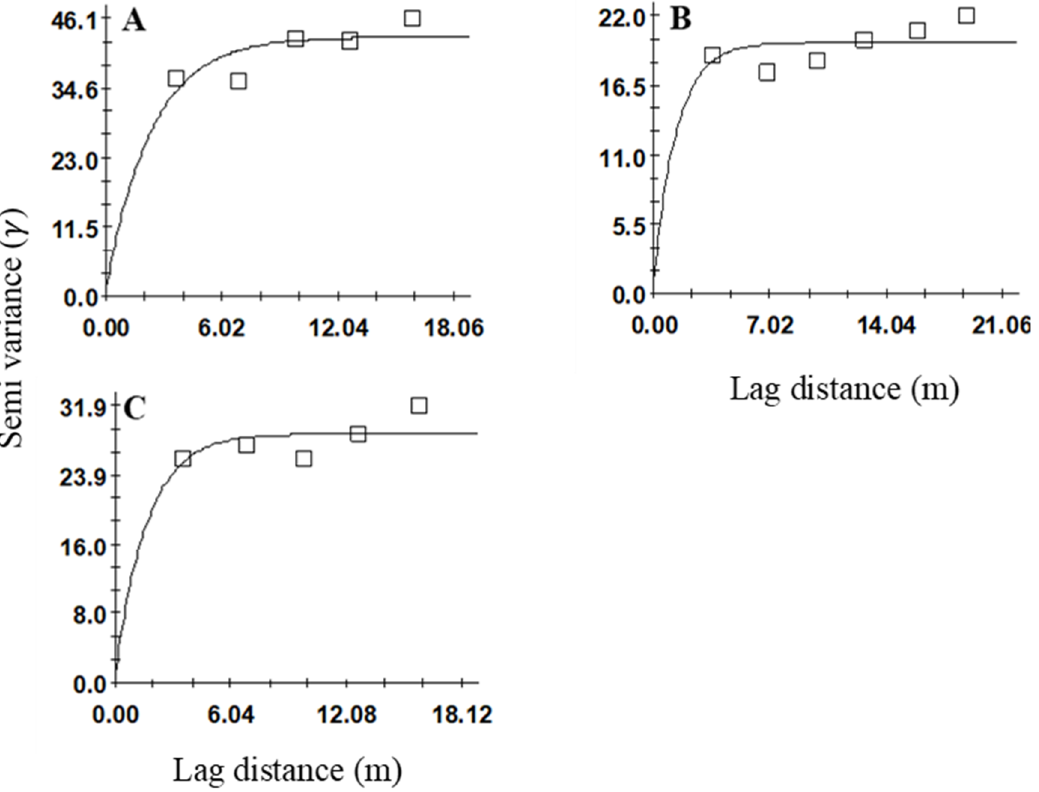
Figure 4. Variogram models showing the spatial distributions of Sphenophorus venatus vestitus adults in sites ( A ) 2, ( B ) 3, and ( C ) 4.